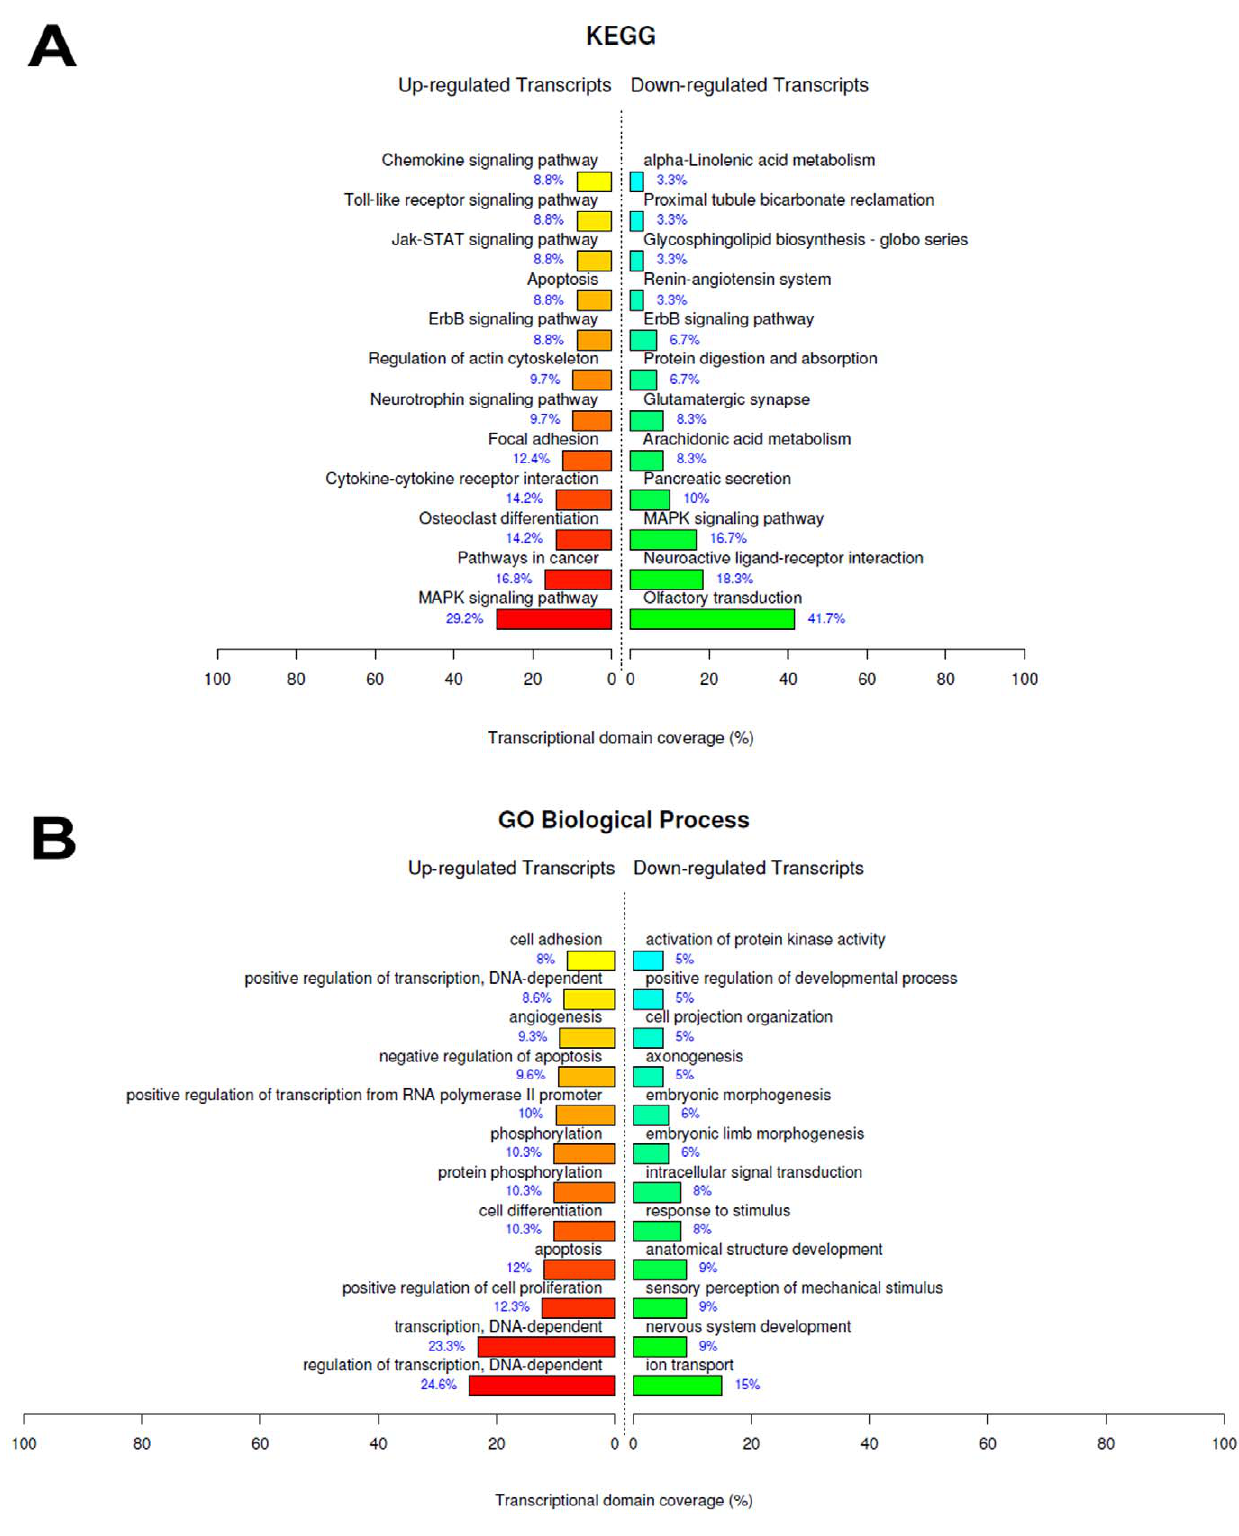
Figure 2. Top ranked biological functions after renal ischemia/reperfusion injury. A) KEGG categories showing significant enriched functions for differentially expressed genes at IRI vs Control comparison; B) Biological Process Ontology (GO) of the differentially expressed genes observed at IRI vs Control comparison. The bar plot represents the percentage of genes differentially expressed and functionally annotated in isolated kidney tissue. Bar plot colors represent up (red) and down (green) regulated genes.